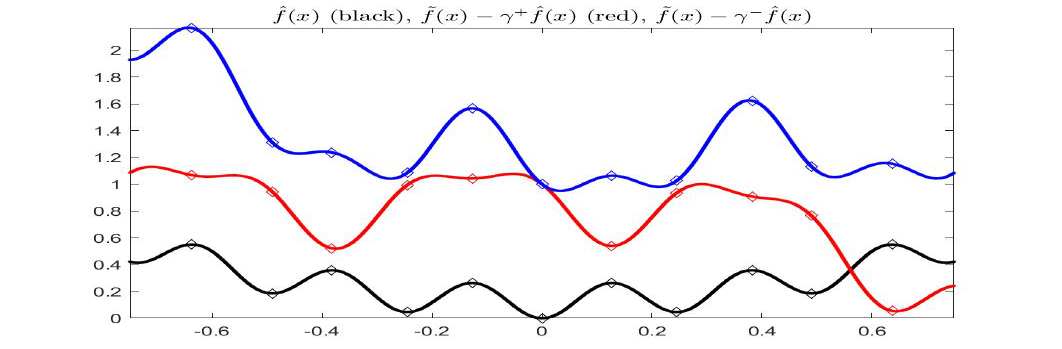
Figure 13. Complete Example: functions (cid:98) f ( x ) , γ + (cid:98) f ( x ) − (cid:101) f ( x ) , (cid:101) f ( x ) − γ − (cid:98) f ( x ) .